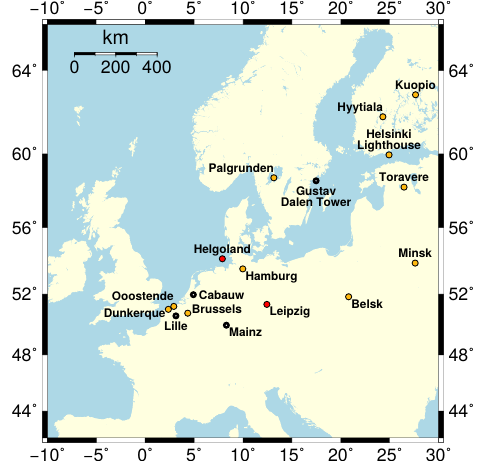
Figure 5. Locations of the EMEP stations at which measured and modeled daily average sodium PM 10 data were compared. Red cir- cles: in addition to statistical data being provided, plots are shown and described in detail. Green circle: an additional comparison of sodium PM 2 . 5 data is presented (DE0044R). Blue box: location of a grid cell which sea salt emissions are presented. Inverted cyan triangles: sodium wet deposition is evaluated.